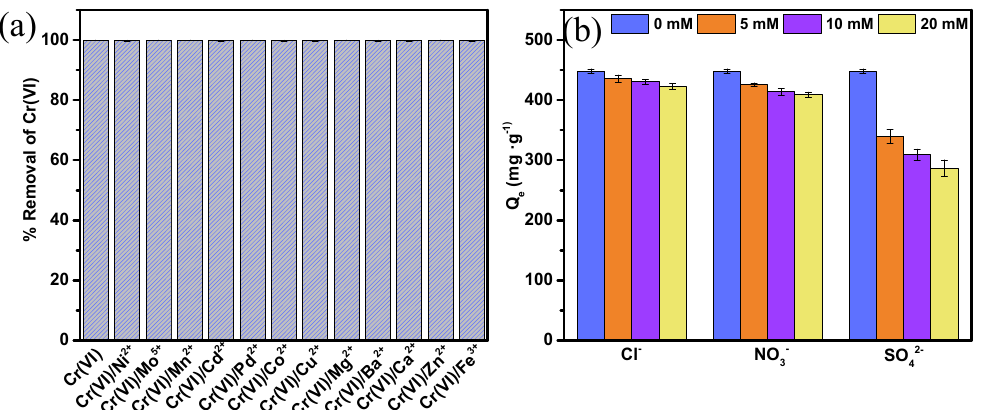
Figure 7. ( a ) Effect of coexistence of cations on adsorption of Cr (VI) by the DAPFP biosorbent; ( b ) effect of the coexistence of anions on the adsorption of Cr (VI) by the DAPFP biosorbent.